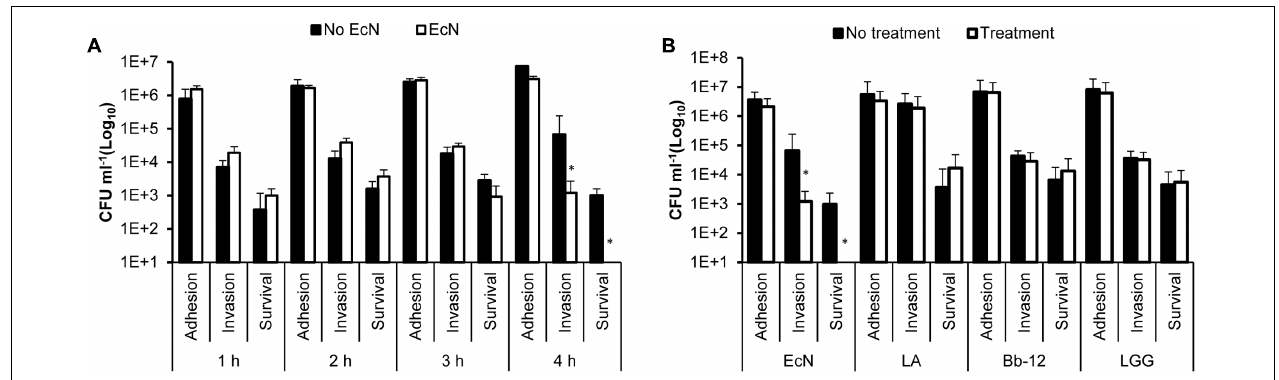
FIGURE 1 | Campylobacter jejuni ’s adhesion to, invasion of and intracellular survival in HT-29 cells pretreated with (A) EcN for 1, 2, 3, and 4 h; (B) EcN, Lactobacillus acidophilus NCFM (LA), Bifidobacterium animalis subsp. Lactis (Bb-12) and Lactobacillus rhamnosus GG (LGG) for 4 h. ∗ Indicates statistically significant